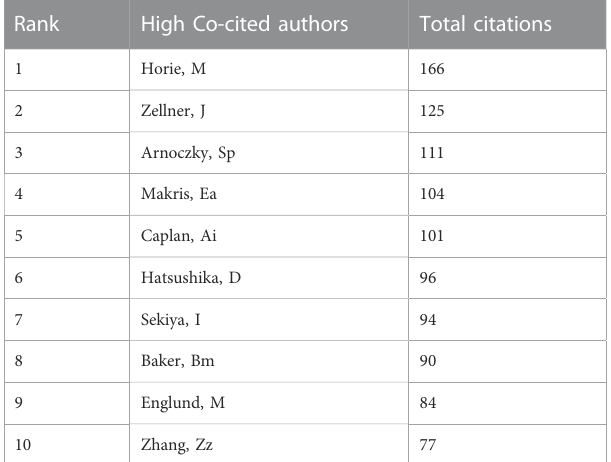
TABLE 10 The top 10 cocited authors on stem cells for meniscal